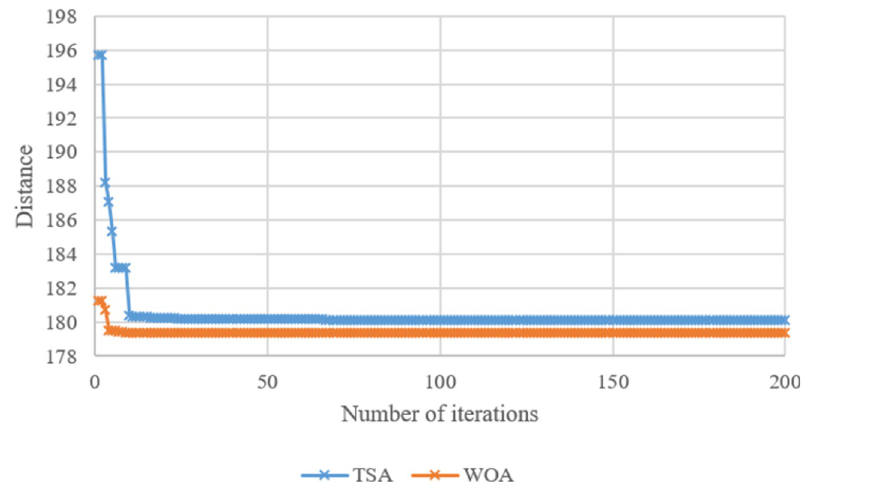
Fig 9. Search history of TSA and WOA for Case- 20 .